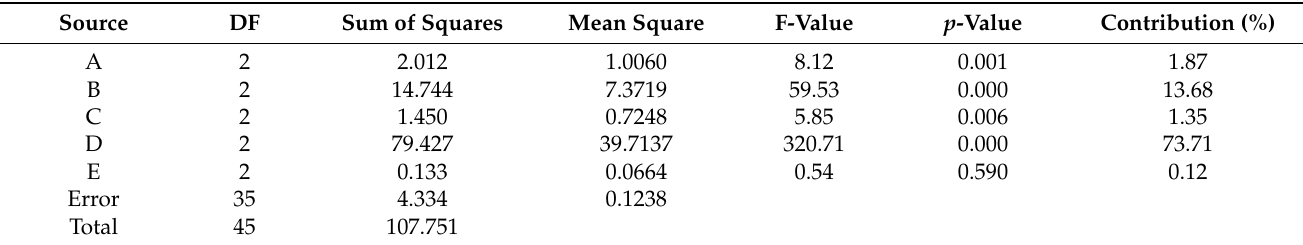
Table 10. ANOVA for volume shrinkage.